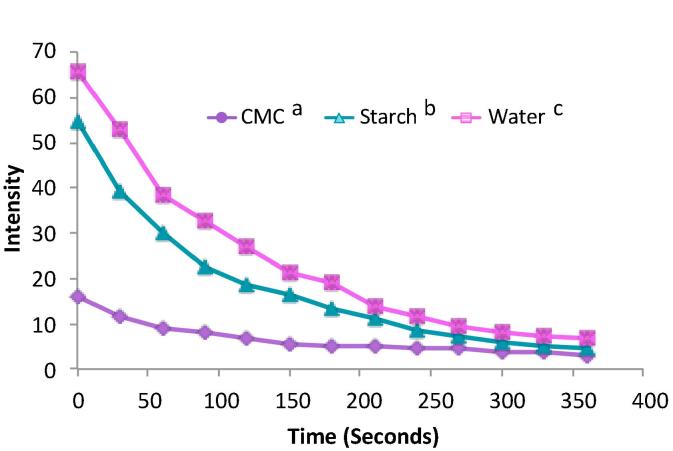
Progressive profiling data for Saltiness. Each data point represents the mean for the 11 panellists and their duplicate tests. Error bars are not included in this graph as there is large individual variation in scores over the time period. The letters next to the sample key represent statistically significant groupings. Different letters represents a significant difference of p ≤ 0.05.